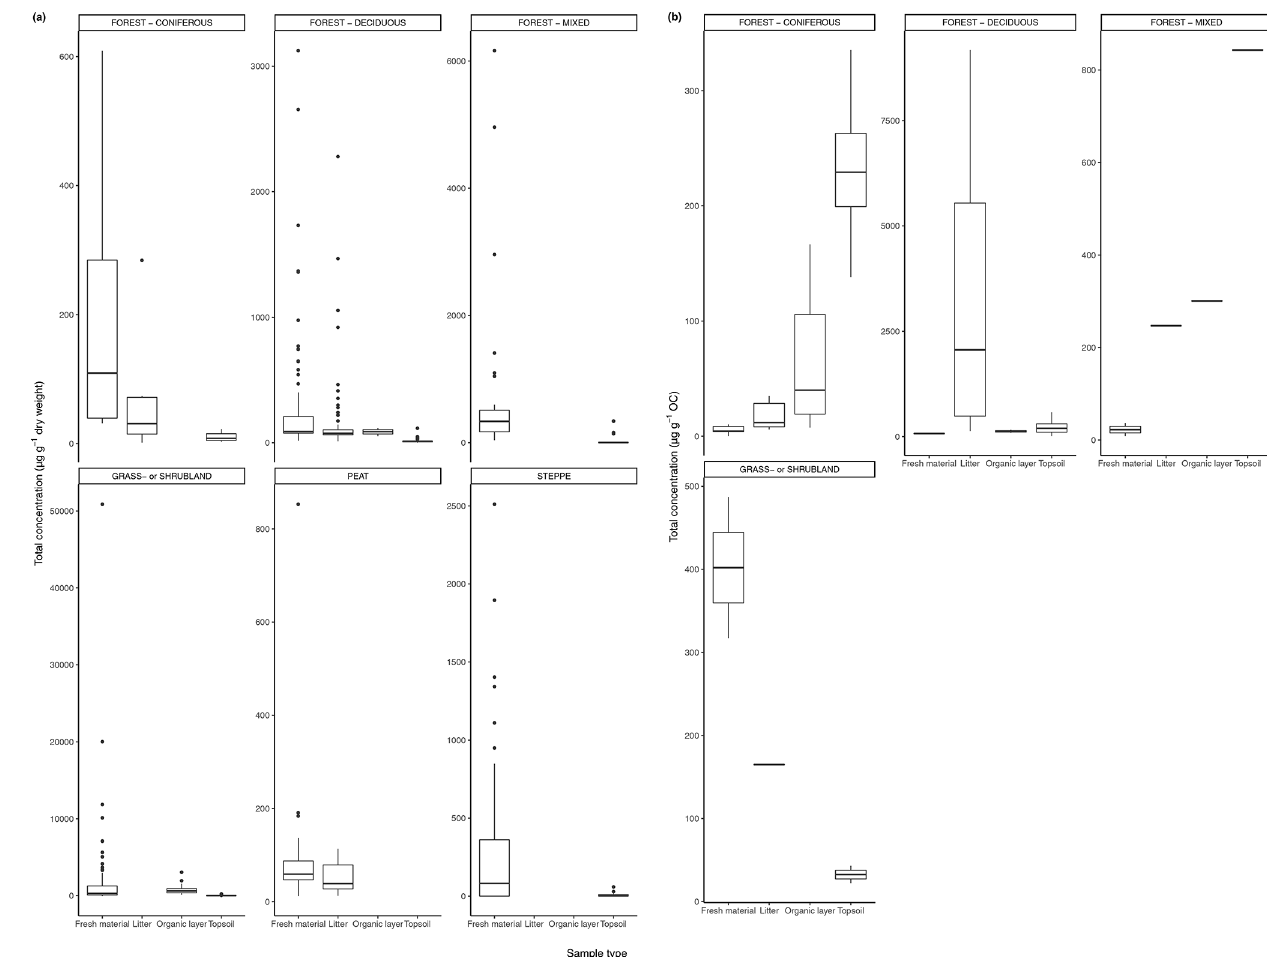
Figure 3. (a) Total concentration (µg/g dry weight) of n -alkanes in fresh leaves, litter, organic layer (litter removed), and topsoil. For the coniferous forest vegetation type, there were nine sites included from one study (Schäfer et al., 2016). For the deciduous forest type, 39 sites were included from seven studies (Bliedtner et al., 2018; Bush and McInerney, 2015; Chikaraishi and Naraoka, 2006; Schäfer et al., 2016; Stout, 2020; Trigui et al., 2019; Wu et al., 2019). For the mixed forest type, 25 sites were included from two studies (Bush and McInerney, 2015; Howard et al., 2018). For the grassland or shrubland vegetation type, 110 sites were included from eight studies (Bliedtner et al., 2018; Bush and McInerney, 2015; Howard et al., 2018; Lemma et al., 2019; Li et al., 2018; Schäfer et al., 2016; Trigui et al., 2019; Yao et al., 2019). For the peat vegetation type, five sites were included from two studies (Ficken et al., 1998; Zhang et al., 2017). For the steppe vegetation type, 57 sites were included from two studies (Struck et al., 2020; Yao et al., 2019). (b) Total concentration (µg/g OC) of n -alkanes in fresh leaves, litter, organic layer (litter removed), and topsoil. For the coniferous forest vegetation type, five sites were included from two studies (Hirave et al., 2020; Otto and Simpson, 2005). For the deciduous forest vegetation type, 11 sites were included from five studies (Angst et al., 2016; Anokhina et al., 2018; Hirave et al., 2020; Otto and Simpson, 2005; Wu et al., 2019). For the mixed forest type, one site was included from one study (Hirave et al., 2020). For the grassland or shrubland vegetation type, two sites were included from one study (Otto and Simpson,